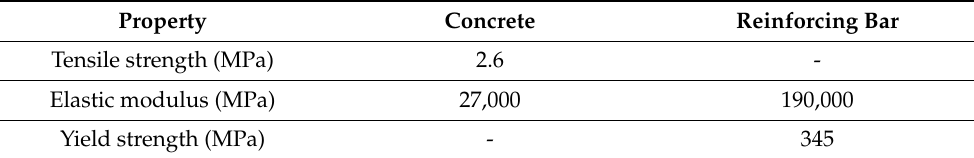
Table 1. Input material properties.